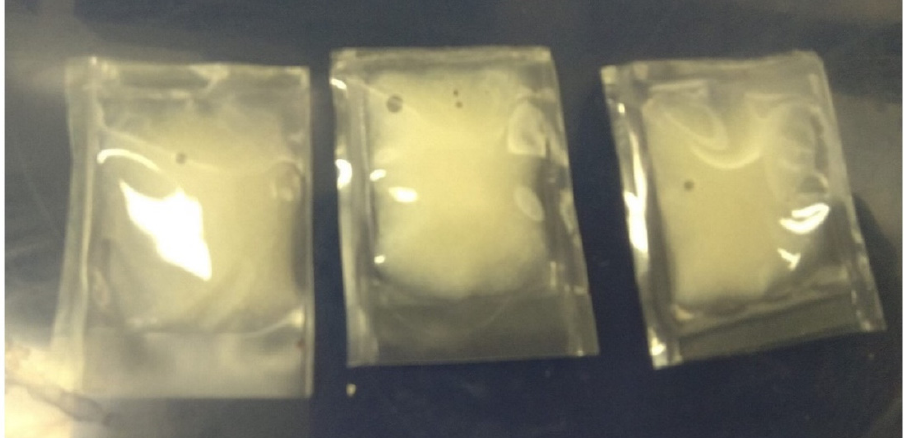
Figure 2. Microwavable pouch (Cryovac BNB1, Barrier Bag–70 Micron, 150 mm × 200 mm packages) containing mashed potato (1 g) inoculated with G. stearothermophilus spores followed by sealing on the four ends using HI Impulse Handsealer (Makmar, Auckland, New Zealand) with a maximum sealing thickness of 0.15 mm and a seal width of 2 mm and a sealing time of 2